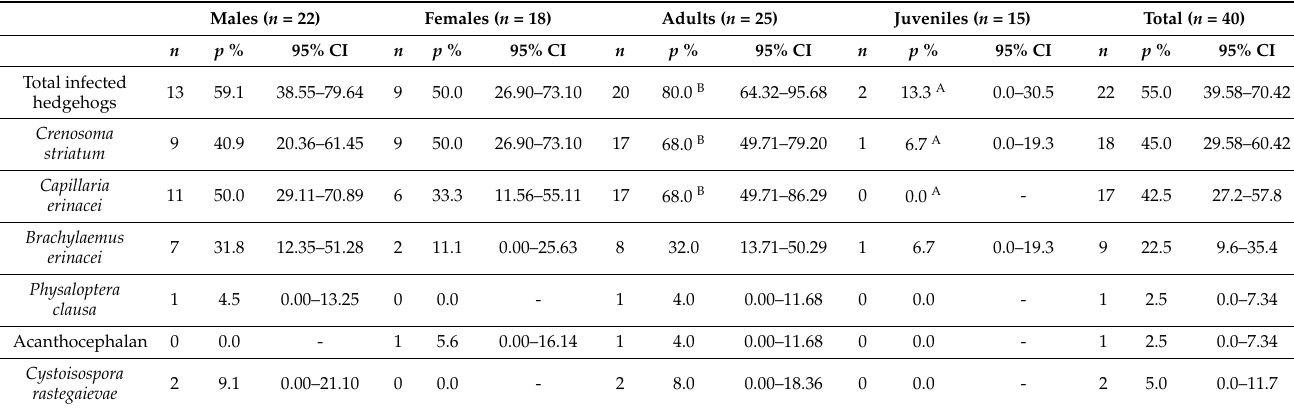
adult parasites are shown above in Figures 1–3.